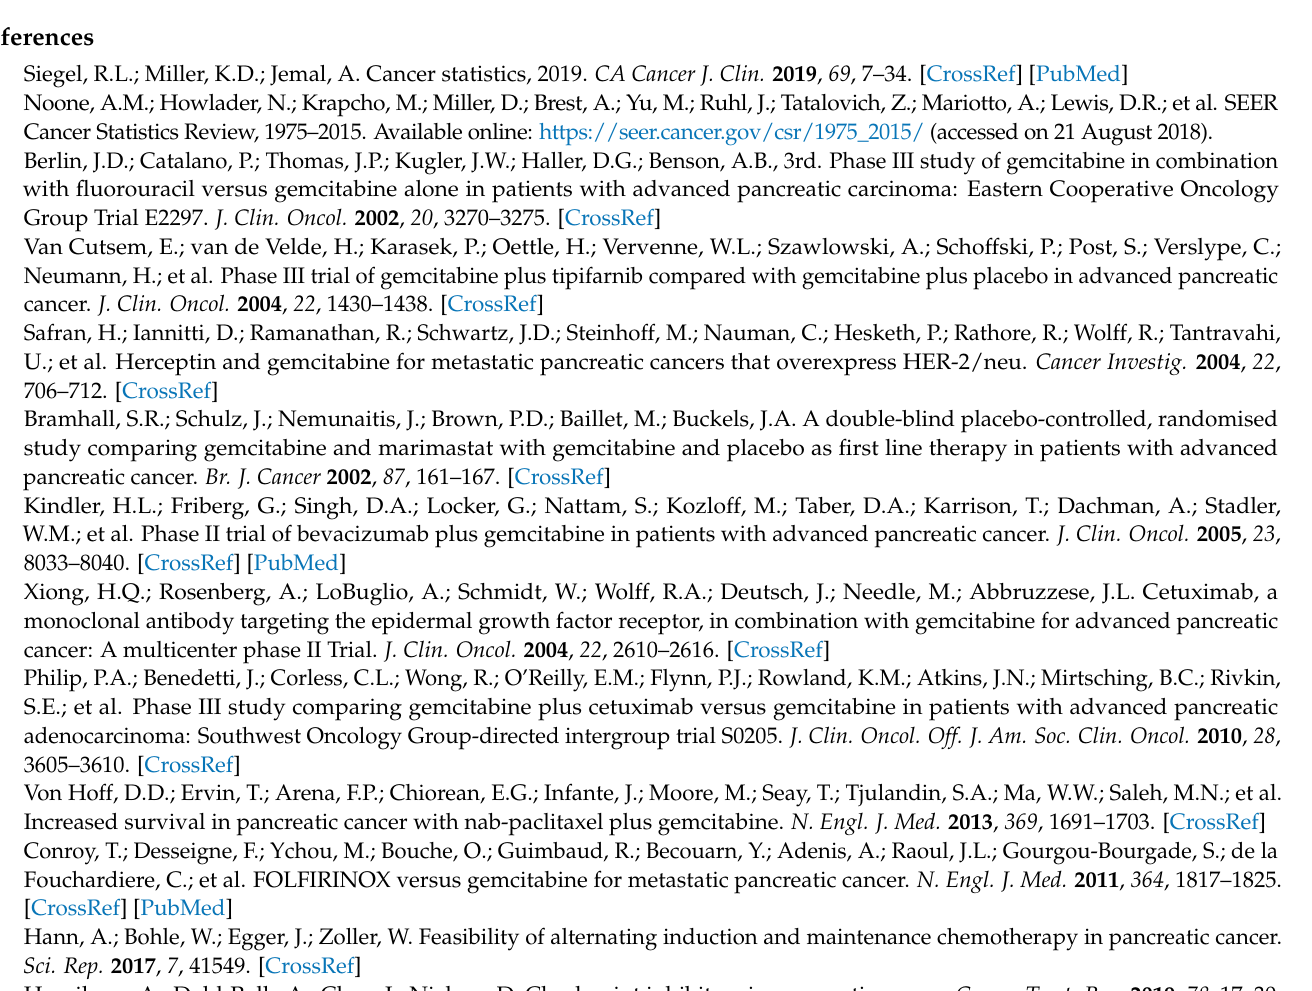
Figure A3. Cell viability of Panc-1 cells in response to increasing Gemzar (gemcitabine) exposure concentrations. Growth curves were plotted by non-linear regression using the variable slope equation in GraphPad prism software. Data represented as mean ± SD.